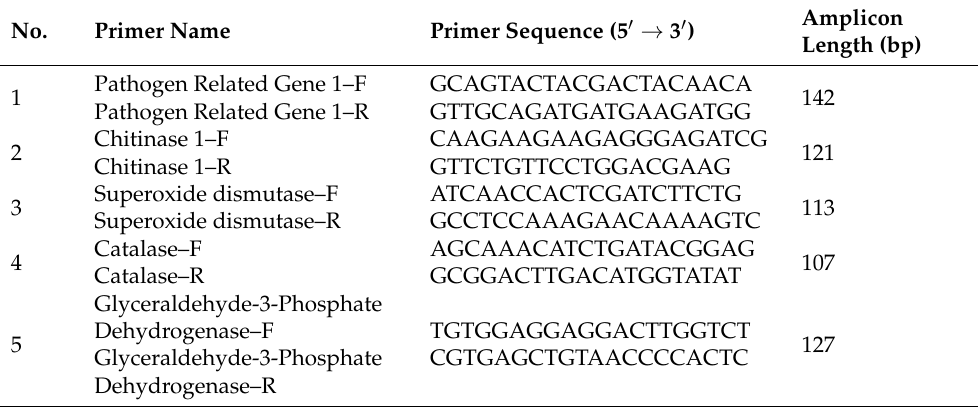
Table 1. Sequence of primers used in this